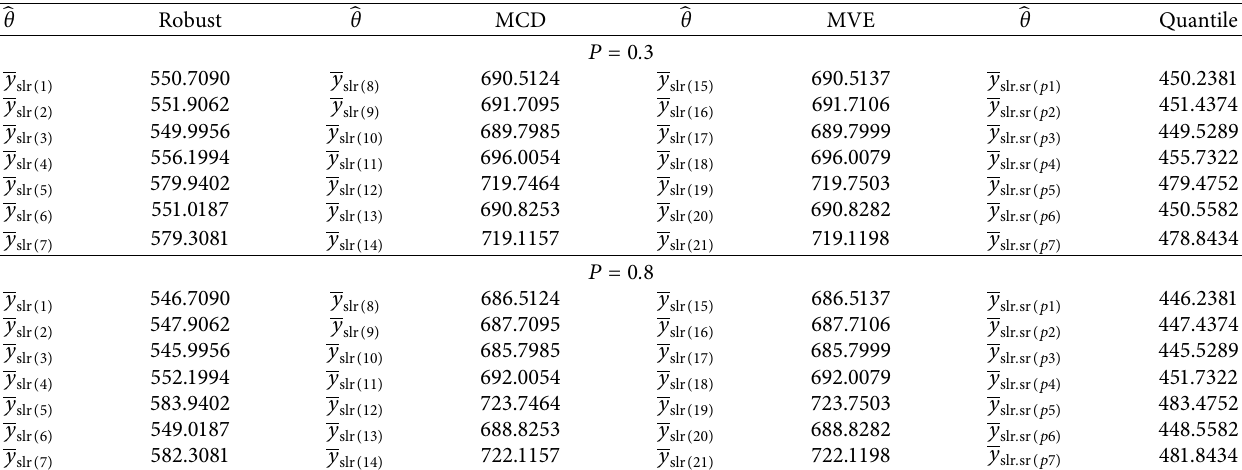
Table 8: Population-2 MSE for the mean estimators of the sensitive variable through using the Bar-Lev model. 􏽢 θ Robust 􏽢